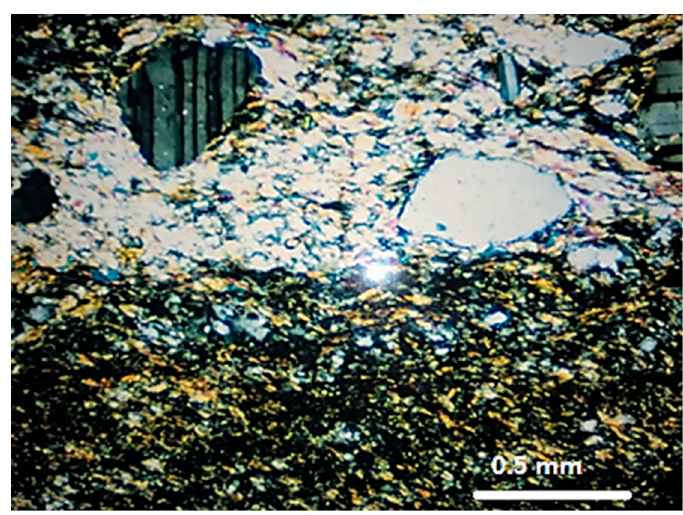
Figure 3. General aspect of the mylonite M3. Segregation of micaceous and quartz-feldspatic bands. Quartz in fine new grains aggregates. Optical microscope under crossed polarizer.